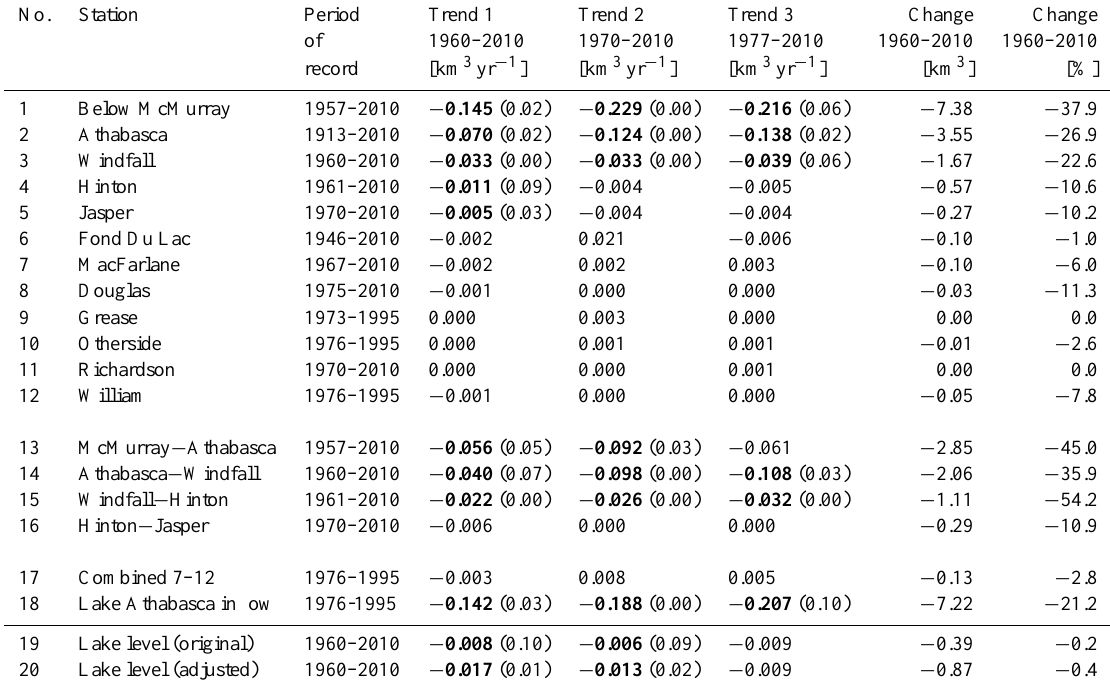
Table 2. Total discharge variability in the different tributaries across the Lake Athabasca basin and detected trends for three different, common analysis periods, 34, 41 and 51yr in duration, with associated discharge changes in comparison to the long-term average. Note that bold values denote significant trends ( p values are shown in parentheses) and that Lake Athabasca level trends and change are in units of myr − 1 and m,